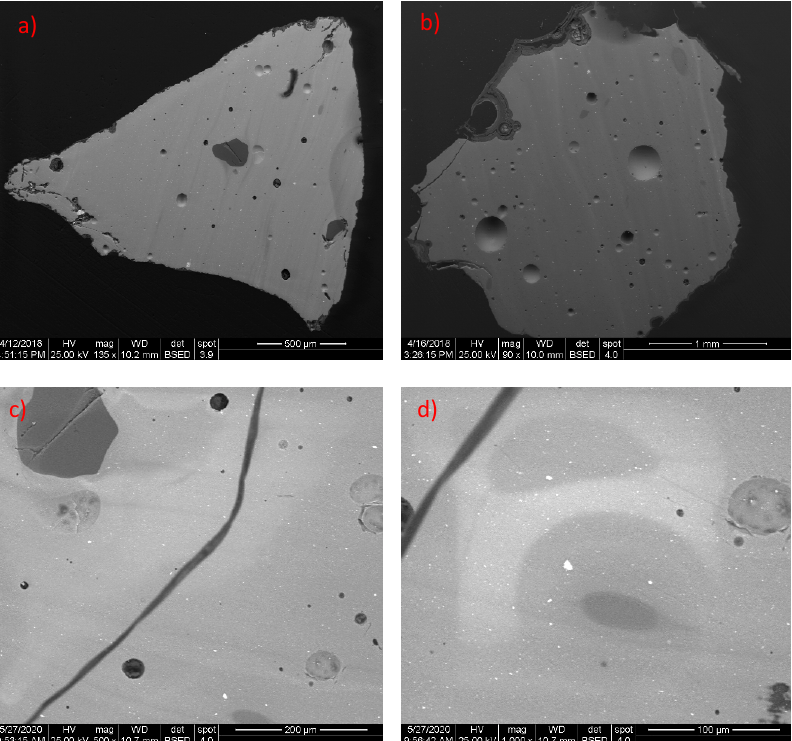
Figure 9. BSE images of the vitreous matrices of ( a ) yellow and ( b ) green tesserae (SSV_Y1 yellow and SSV_G6 green natron-based tesserae from the monastic complex of San Severo in Classe, Ravenna, Italy—unpublished data). Please note the non-homogeneous textures with zoned bands ( c ) and dotted with unevenly distributed micrometric and sub-micrometric crystals, either alone or in clusters ( d ).